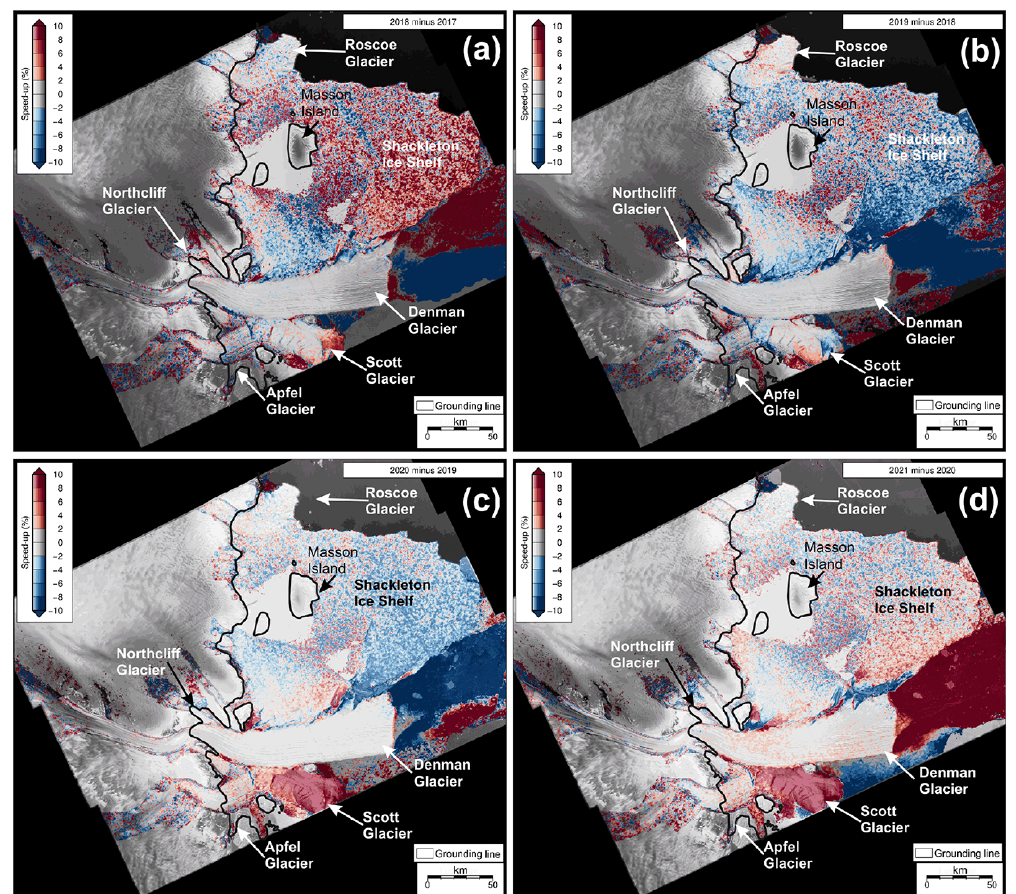
Figure 10. Percentage difference in mean speed between (a) 2018–2017, (b) 2019–2018, (c) 2020–2019 and (d) 2021–2020 scaled between ±